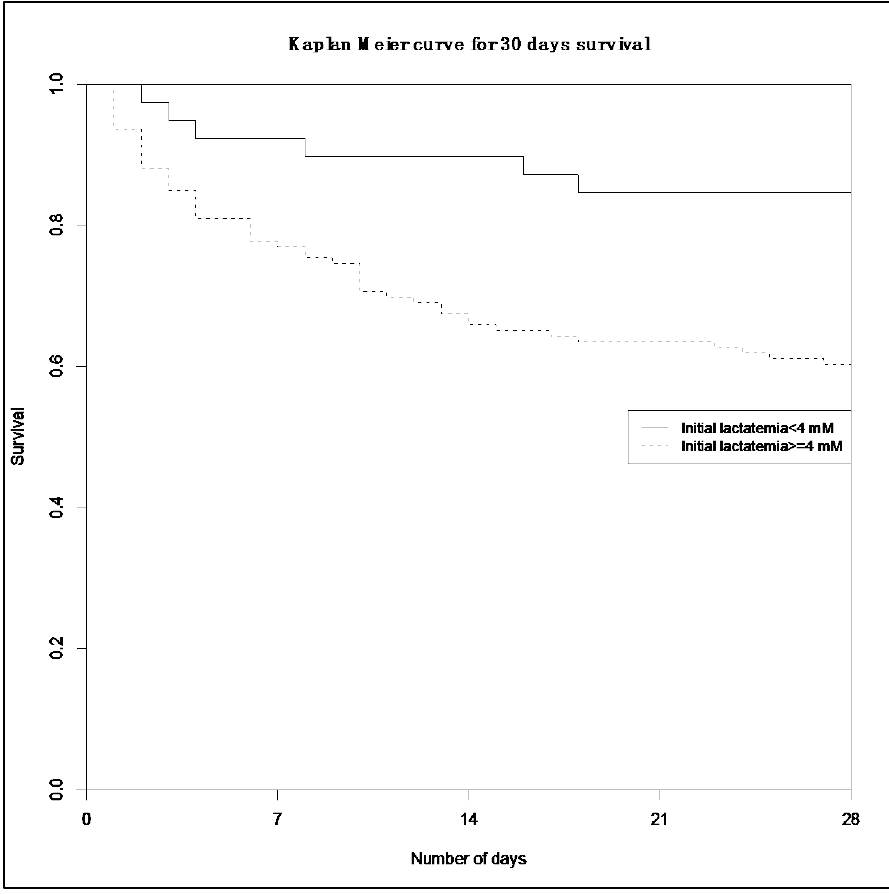
Figure 3. Kaplan Meier curve of 30-day survival.